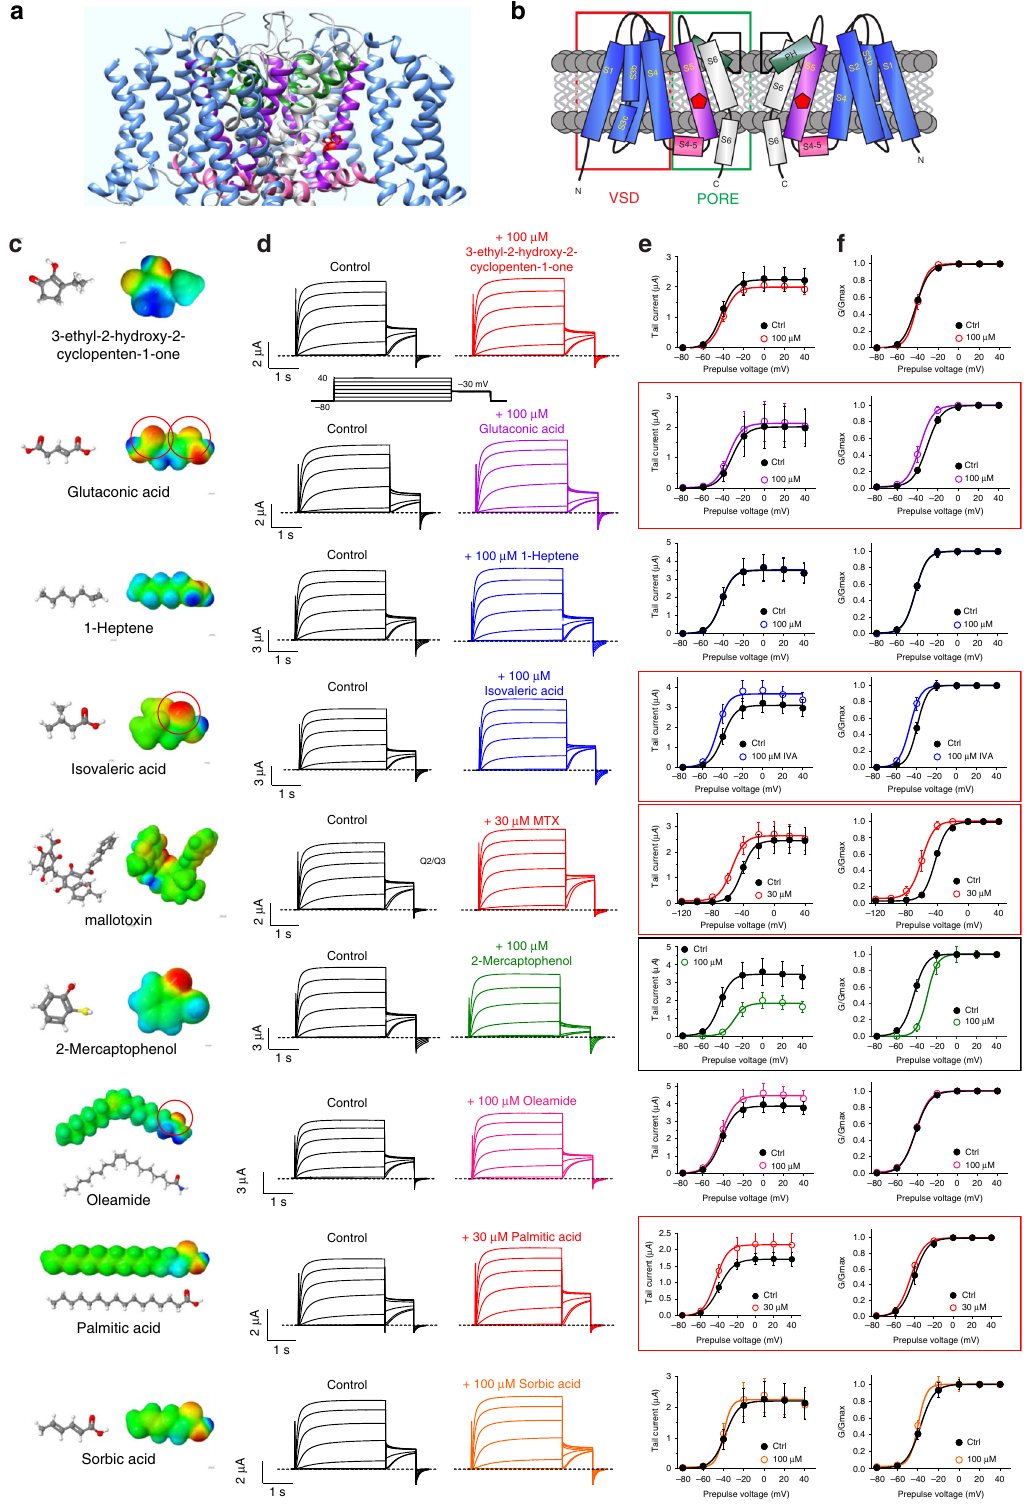
Fig. 1 Multiple M. oppositifolius leaf extract compounds activate KCNQ2/3. a KCNQ1 – KCNQ3 chimeric structure model. b KCNQ topology (two of four subunits shown). VSD voltage-sensing domain. c Structure and electrostatic surface potential (blue, positive; green neutral; red, negative) of M. oppositifolius leaf extract components. Open red circles highlight strongly negative electrostatic surface potential. d Averaged KCNQ2/3 current traces in response to voltage protocol (upper inset) when bathed in the absence (Control) or presence of M . oppositifolius leaf extract components ( n = 4 – 16). Dashed line indicates zero current level in this and all following current traces. e , f Mean effects of leaf extract components (as in d ; n = 4 – 16) on: e KCNQ2/3 raw tail currents at − 30 mV after prepulses as indicated; f G / G max . Error bars indicate SEM. Red boxes indicate KCNQ2/3 activation; black box indicates KCNQ2/3 inhibition